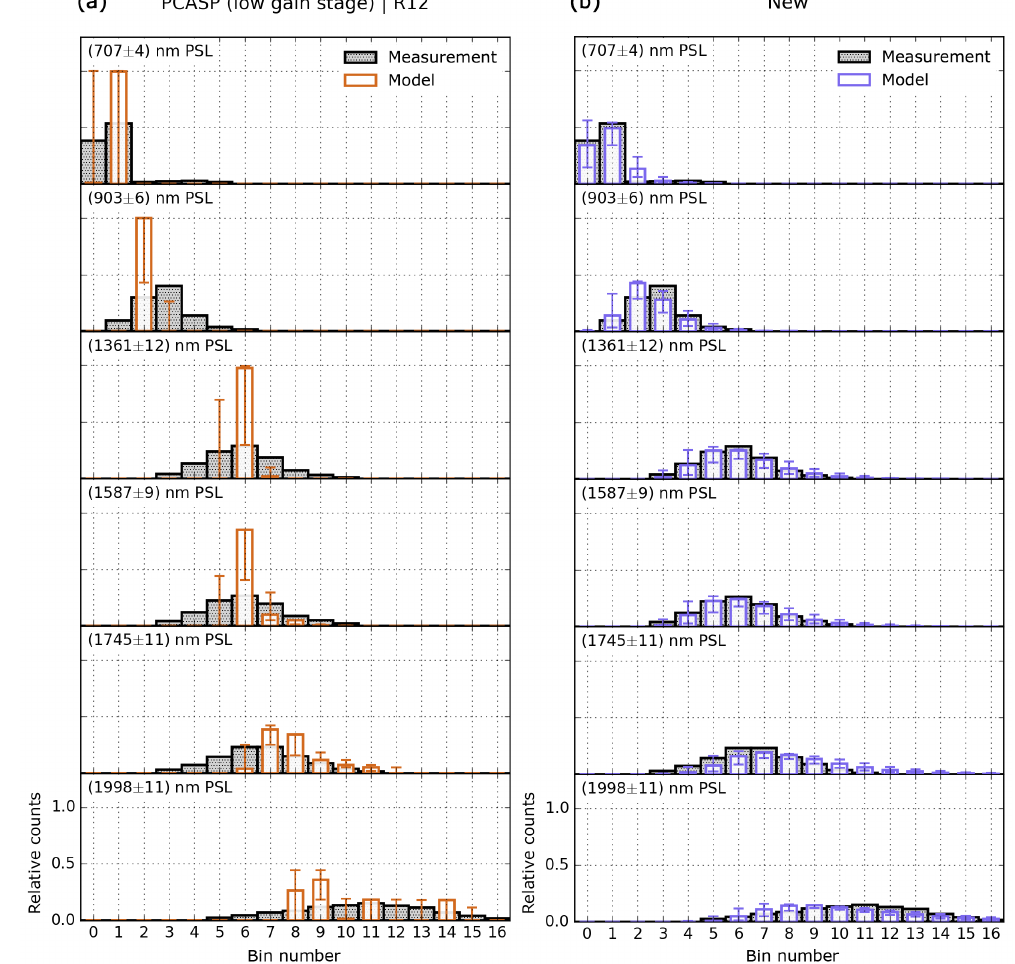
Figure 5. Same as Fig. 4 but for the PCASP and a different set of PSL particle standards. Instead of the PCASP (low gain stage) default binning, a custom high-resolution linear partitioning is applied here to better highlight the differences between the